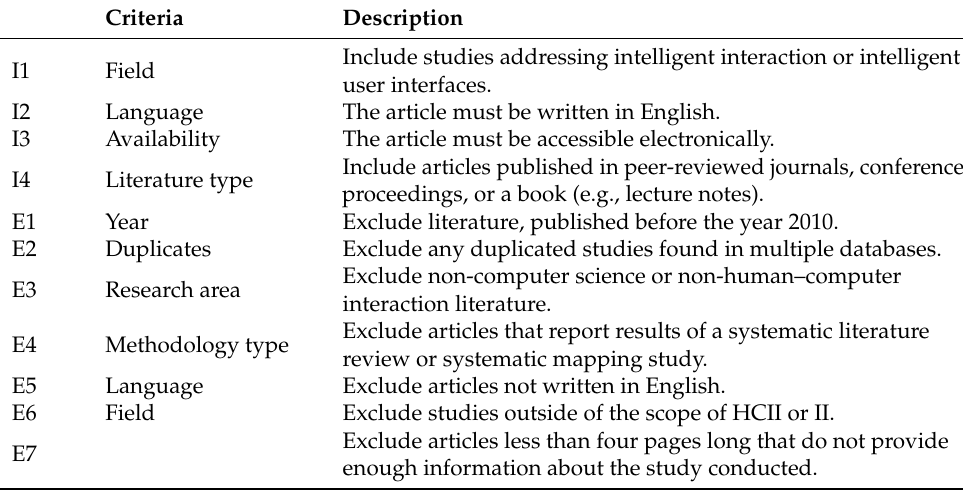
Table 3. Inclusion and exclusion criteria.